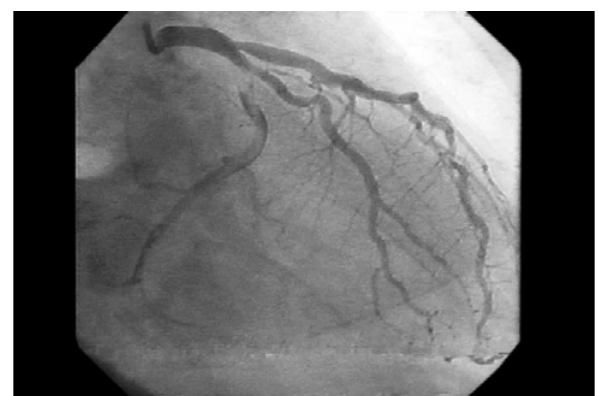
Fig. 1 - Dissecção em coronária circunflexa visualizada durante